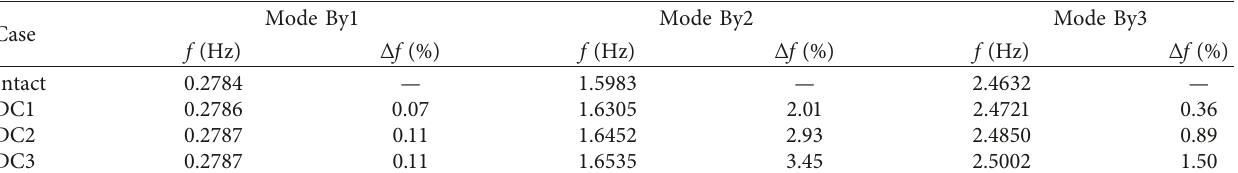
Table 12: Natural frequencies of across-wave bending modes: damage type 2.